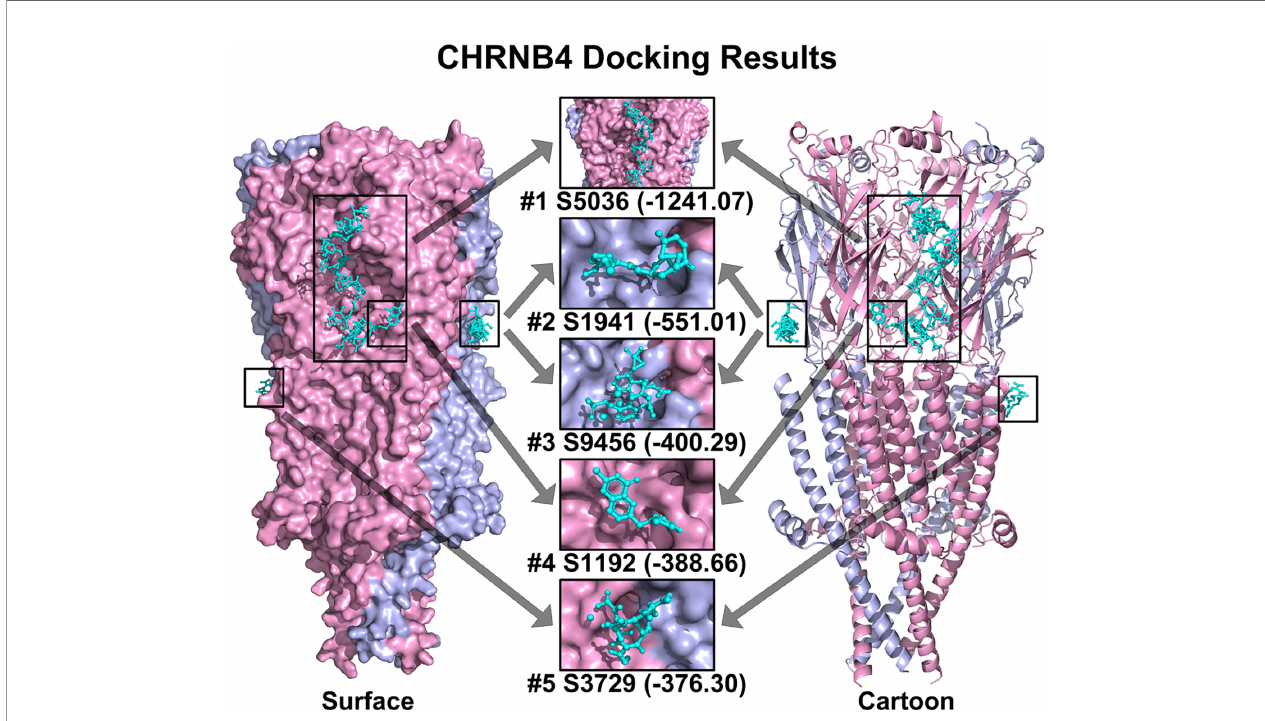
FIGURE 6 | Top 5 ranked small molecules in CHRNB4 docking analysis. The protein structure of CHRNB4 is illustrated in surface format (left) and cartoon format (right) with different chains colored in pink and light blue. The top 5 ranked small molecules in docking analysis together with their docking scores are colored in cyan and highlighted in rectangular. (S5036, Nisin; S1941, Enalapril maleate; S9456, Mangafodipir Trisodium; S1192, Raltitrexed; S3729, Iron